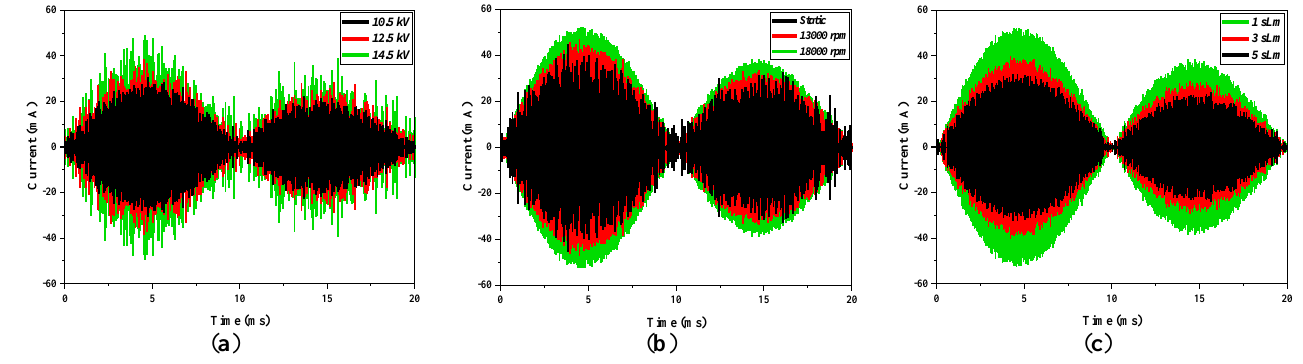
Figure 2. The current waveforms of the plasma discharge versus ( a ) different voltages applied on the stationary power electrode at 1 sLm gas flow rate, ( b ) rotational frequencies of power electrode at 14 kV applied voltage and 1 sLm gas flow rate, and ( c ) gas flow rates at 14 kV applied voltage and 18,000 rpm rotational frequency of the power electrode.